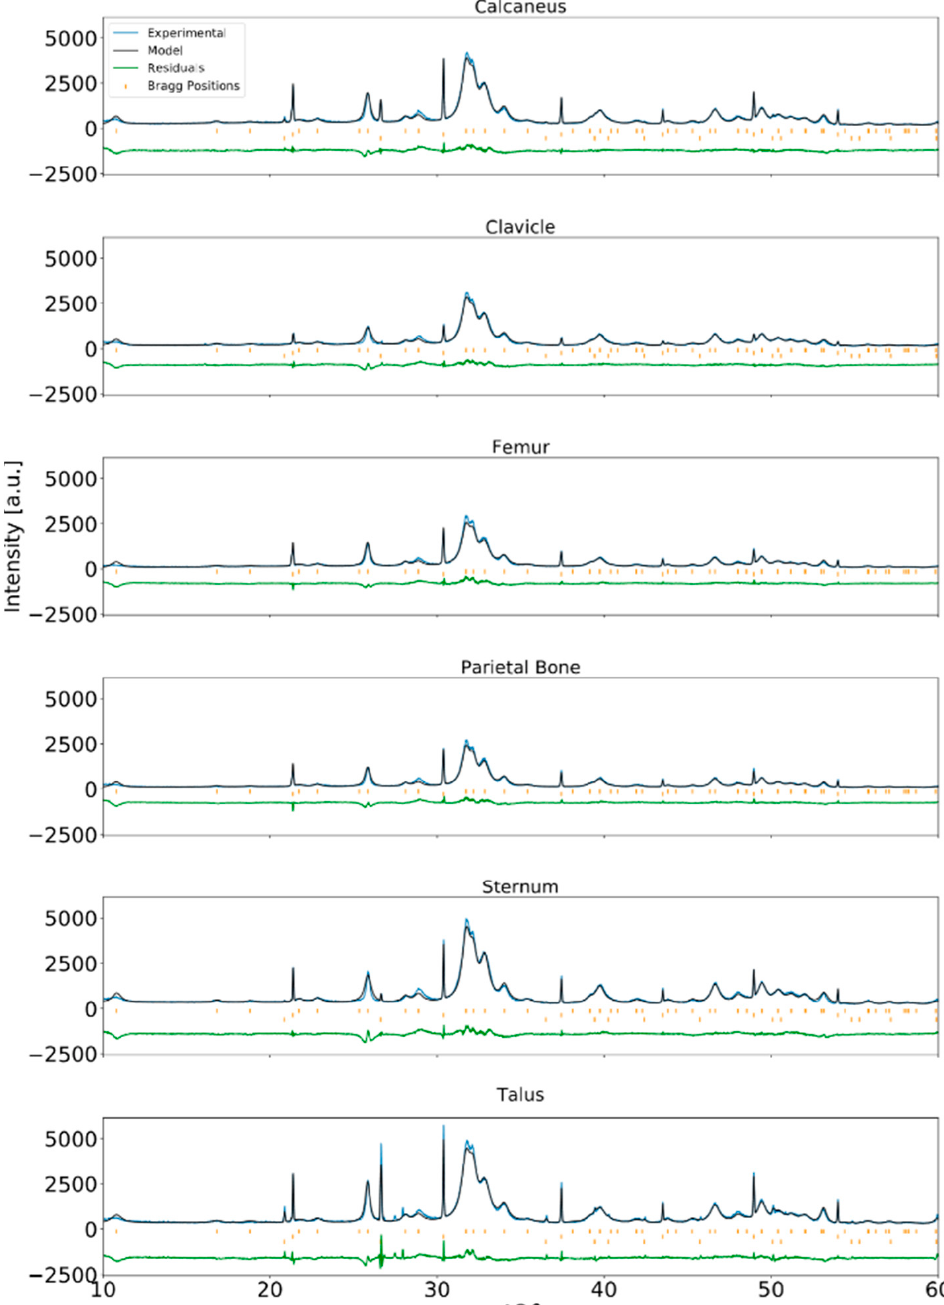
Figure A3. Rietveld refinement of XRPD data for human bone from an ABM adult and internal standard NIST LaB 6 incorporated at approximately 2 wt% ( λ = Cu-K α 1 ).